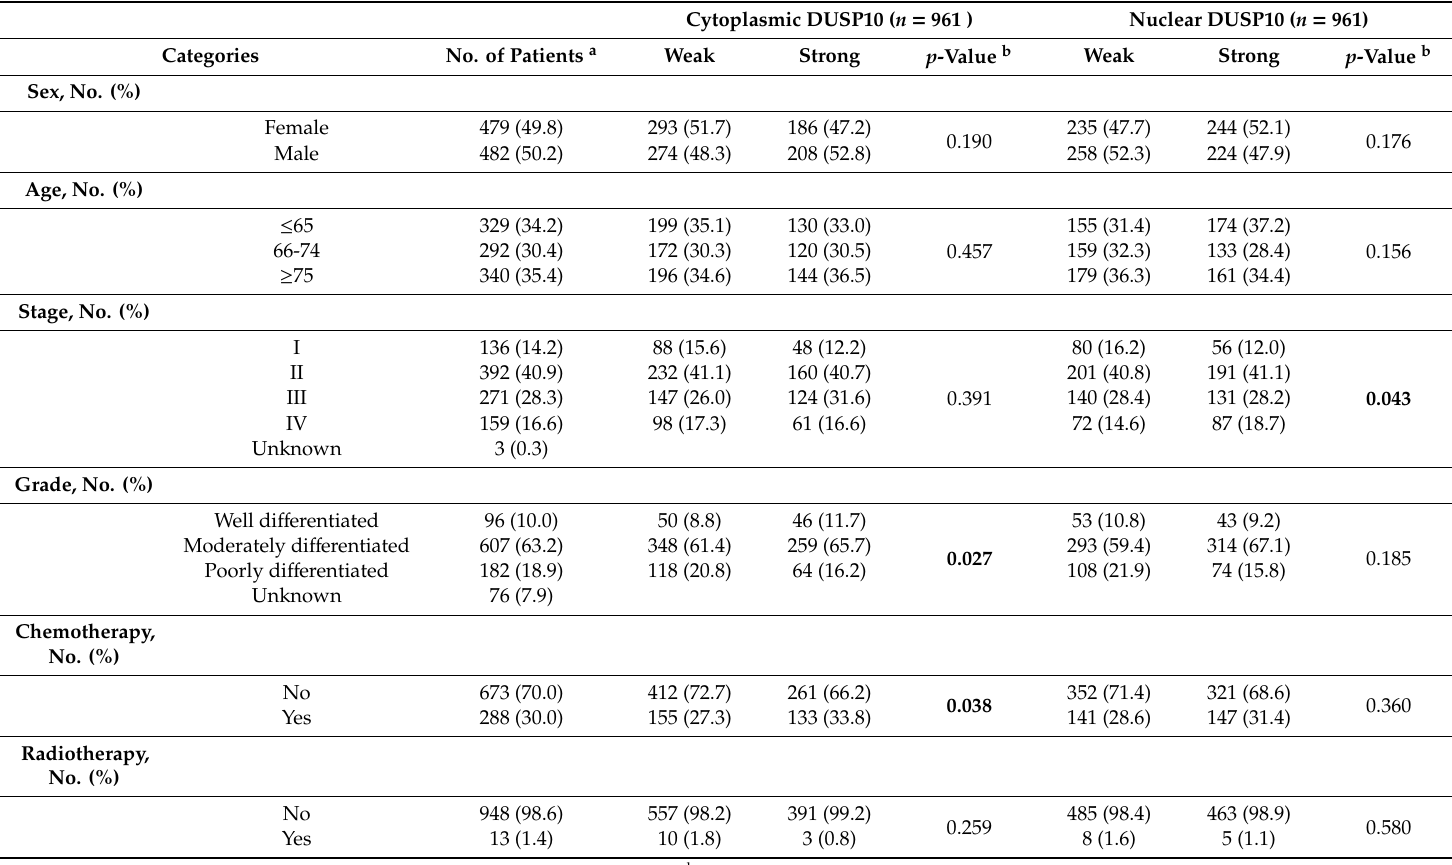
Table 2. Analysis of DUSP10 expression in colon cancer tissue according to clinical-pathological categories. DUSP10 expression was analyzed in tumor epithelial tissue from a cohort of 999 patients depending on clinical-pathological categories (sex, Dukes’ stage, grade of di ff erentiation, origin, or patient’s status). Two-way ANOVA analysis was performed to study the patient